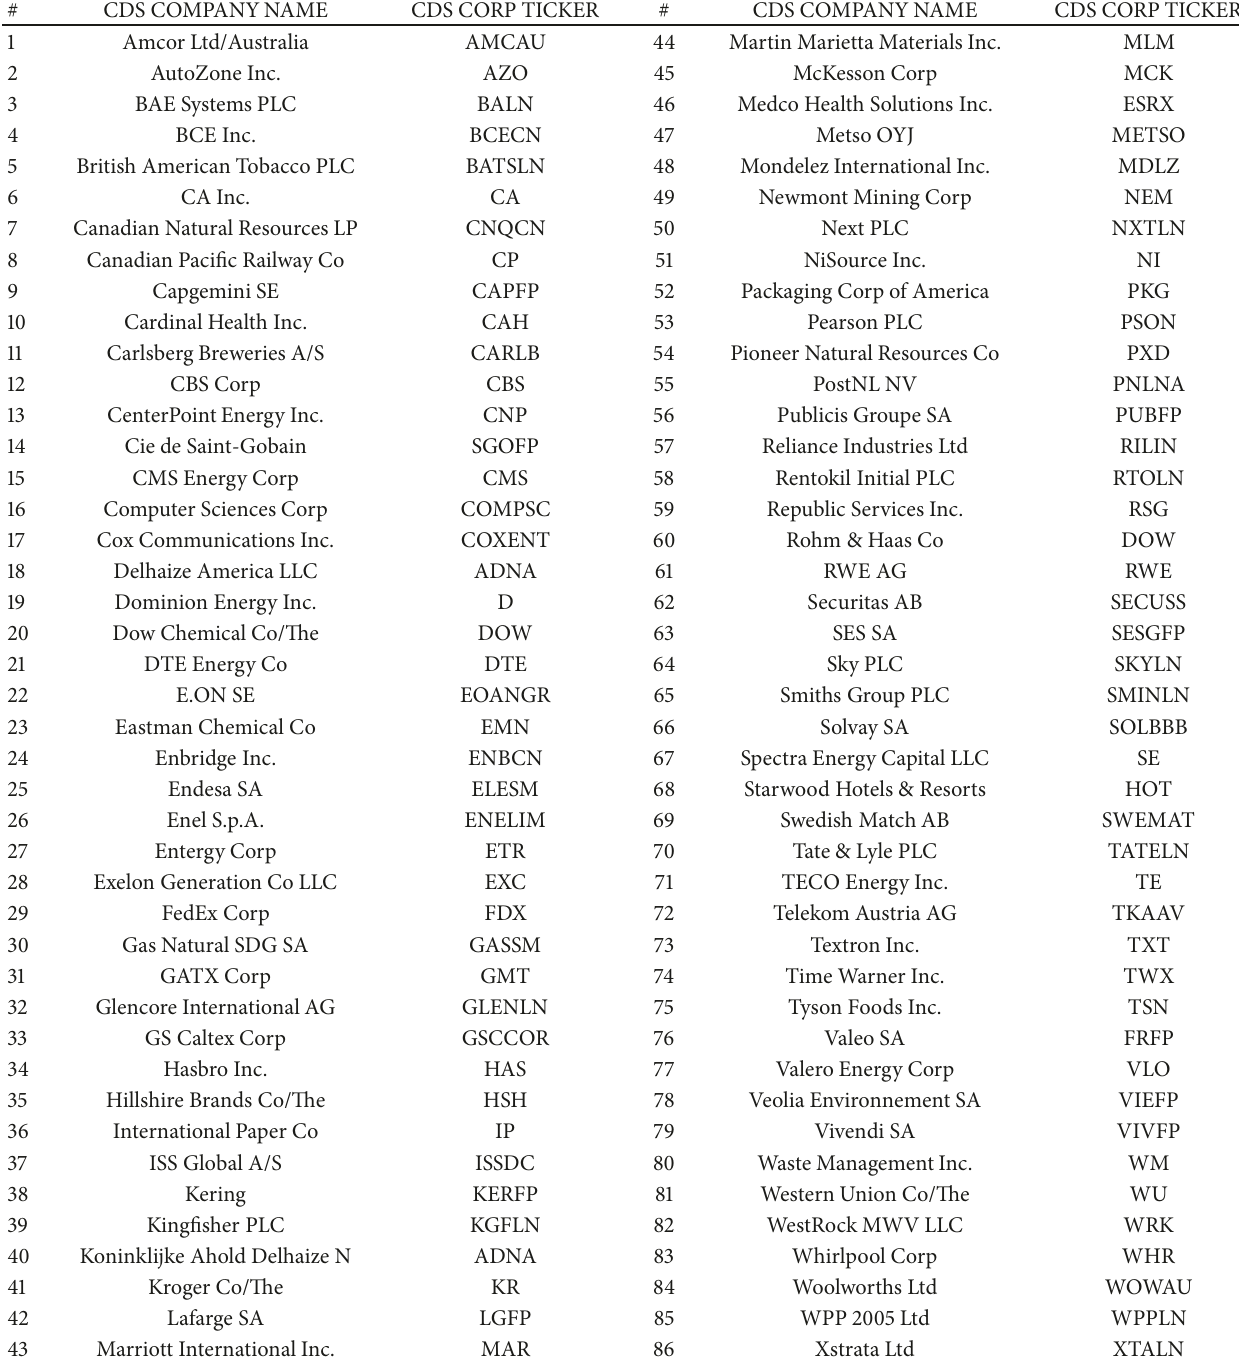
Table 6: Companies used for the IG BBB